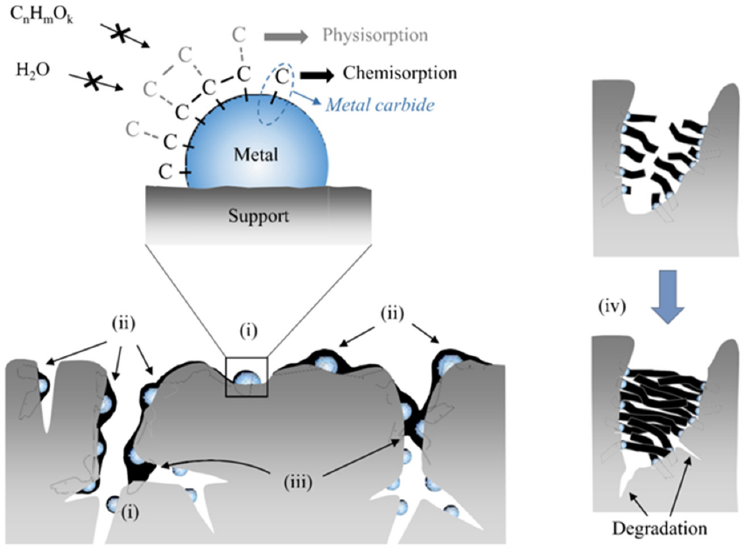
Figure 8. Deactivation pathways by coke formation. Ochoa et al. [17].